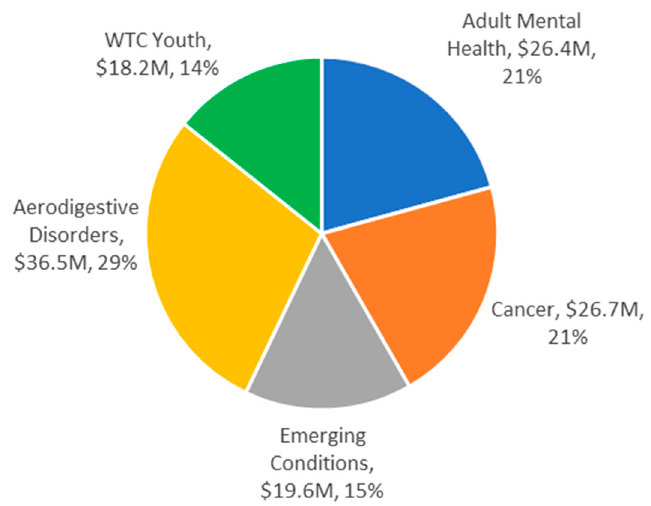
Figure 1. WTCHP Research funding in 2011–2020 by focus area (excluding Registry funding). “WTC Table 2. WTCHP research funding from 2011 through June 2020 by group of interest *. Solicitation and Award Subpopulation (U01